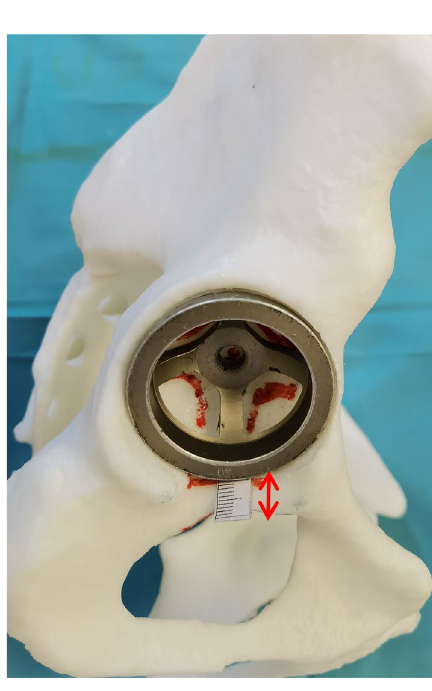
Figure 2. The position relationship between the inferior edge of acetabular cup and PLAPAN to determine cup